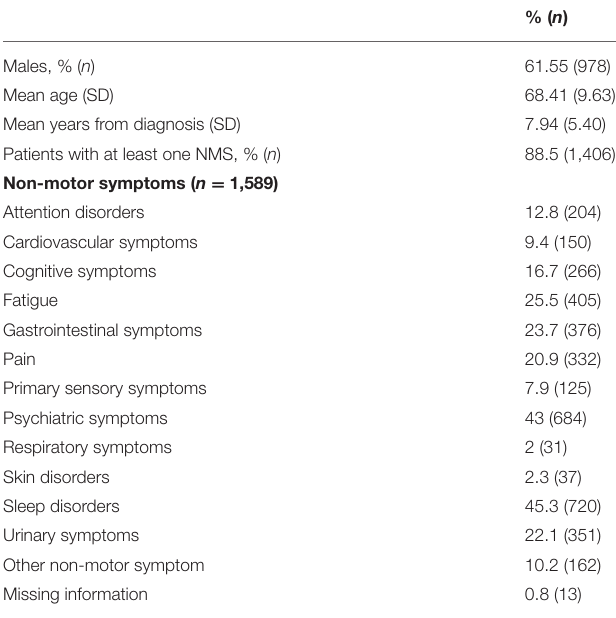
TABLE 2 | Distribution of non-motor symptoms in idiopathic Parkinson’s disease blocking for gender.